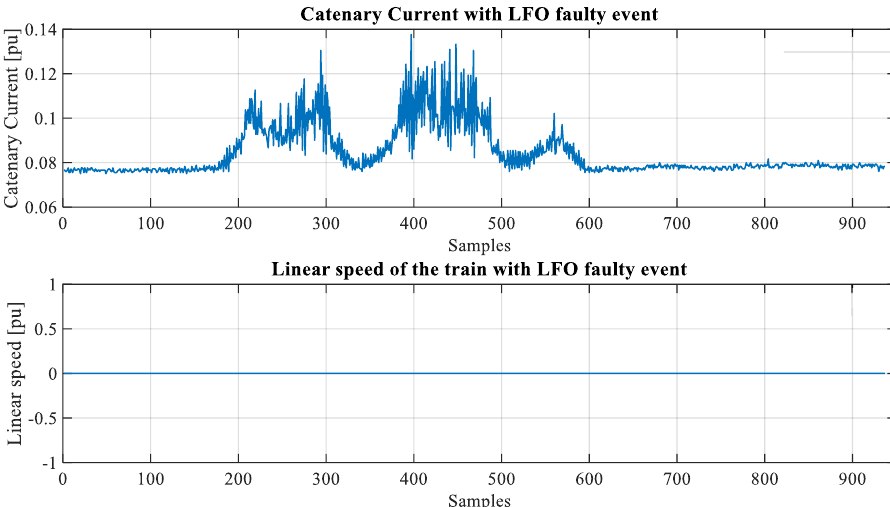
Figure 4. Catenary current and speed (pu) under LFO faulty event